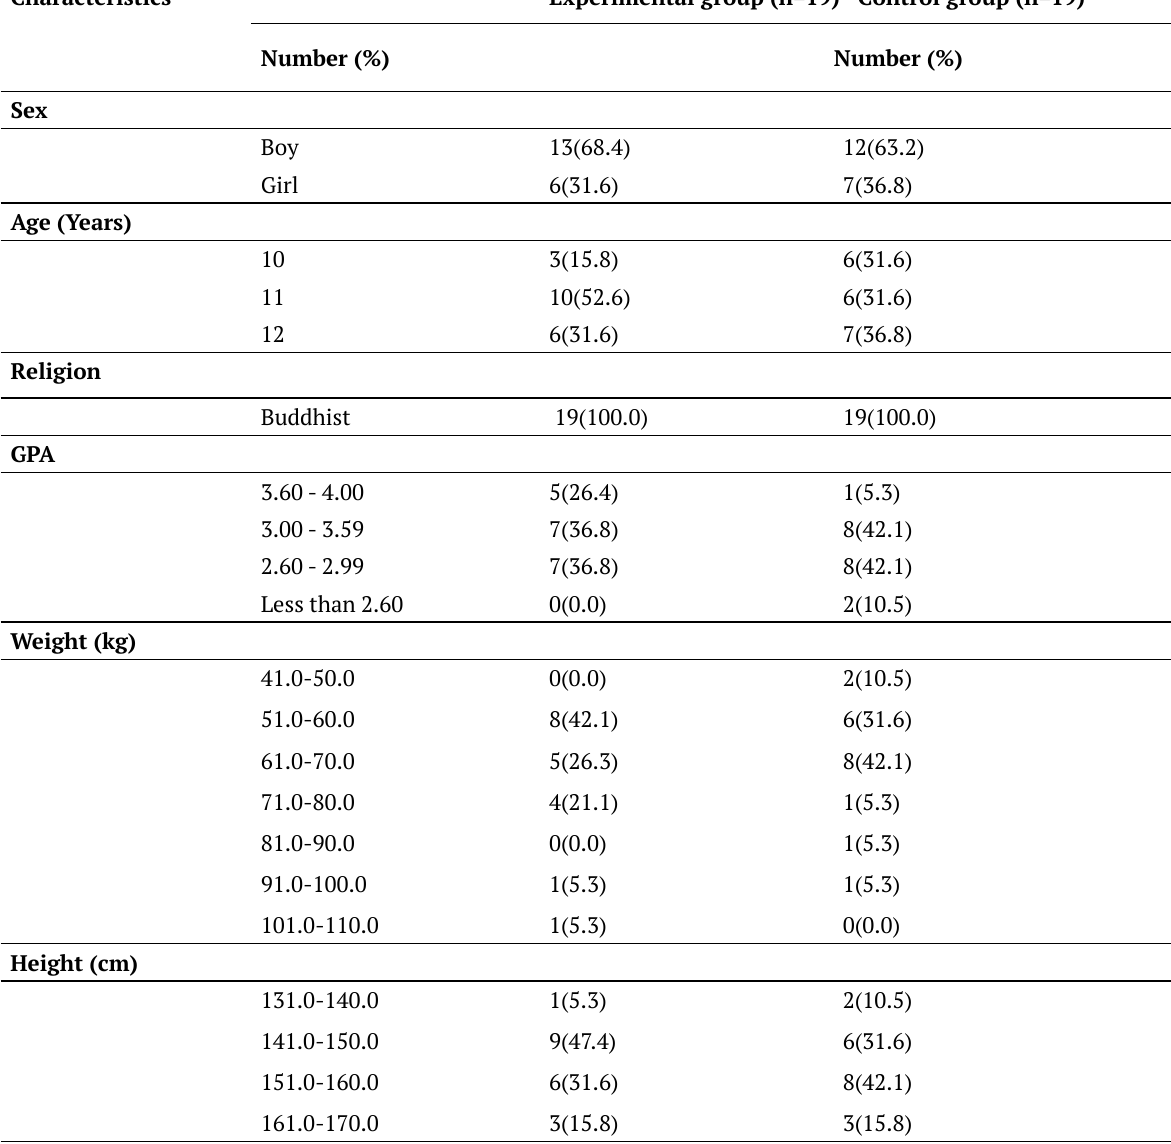
Table 2. Characteristics of participants Characteristics